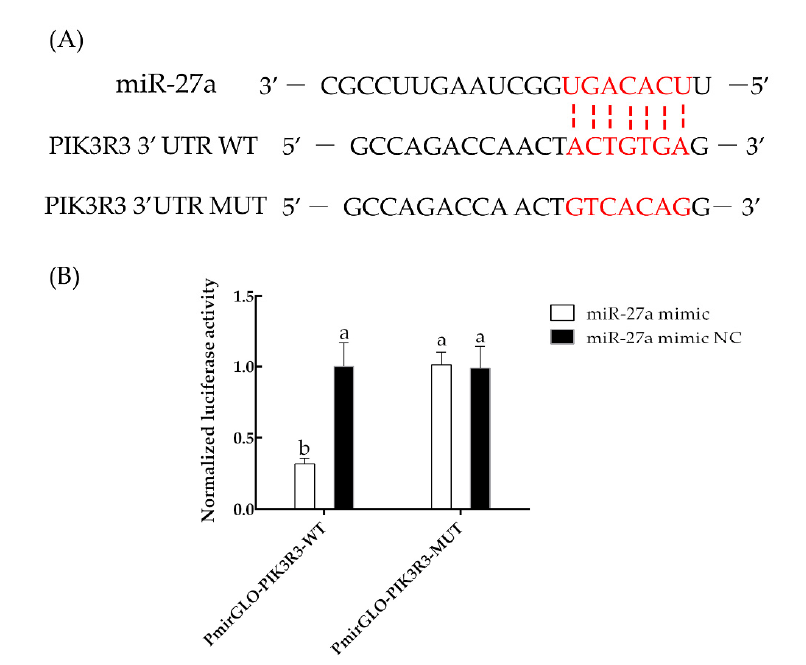
Figure 5. The miRNA miR-27a targets PIK3R3 mRNA. ( A ) Sequence alignment of miR-27a and the 3 ′ -untranslated region (UTR) of PIK3R3 as determined with RNAv22. The different small letters (a, b) in the same graph indicate that the difference between groups is statistically significant ( p < 0.05). ( B ) Luciferase activities in cells transfected with a luciferase plasmid containing the wild-type (WT) or mutated (MUT) PIK3R3 3 ′ UTR and either the miR-27a mimic or a negative control (NC).